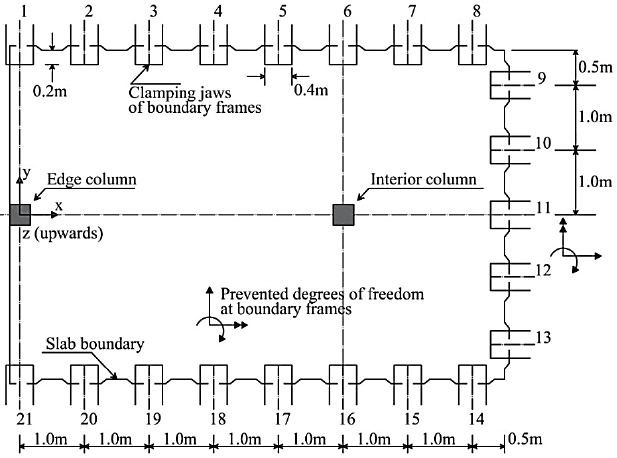
Figure 2. Specimen tested by Sherif and Dilger [6].